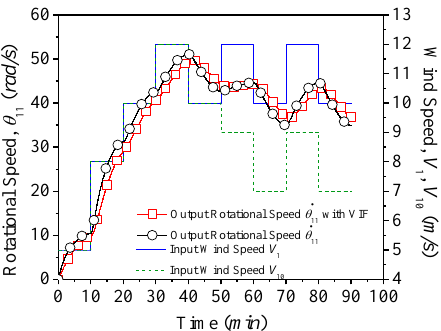
Figure 18. Output power variation.